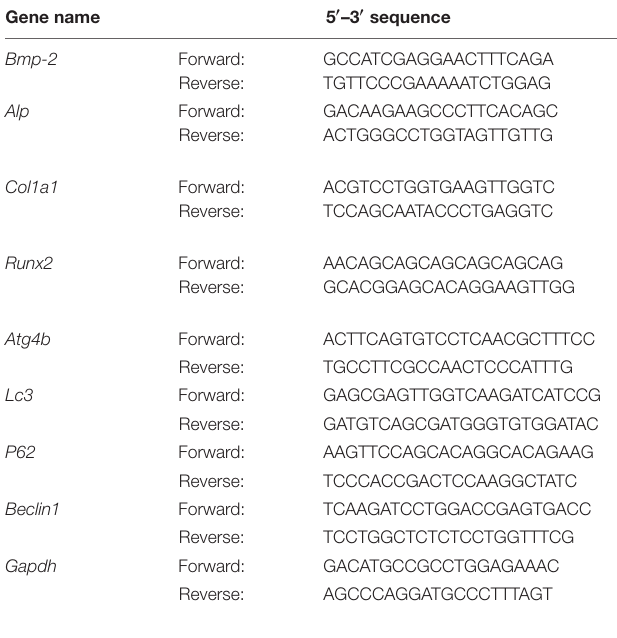
TABLE 1 | The gene primer sequences of the